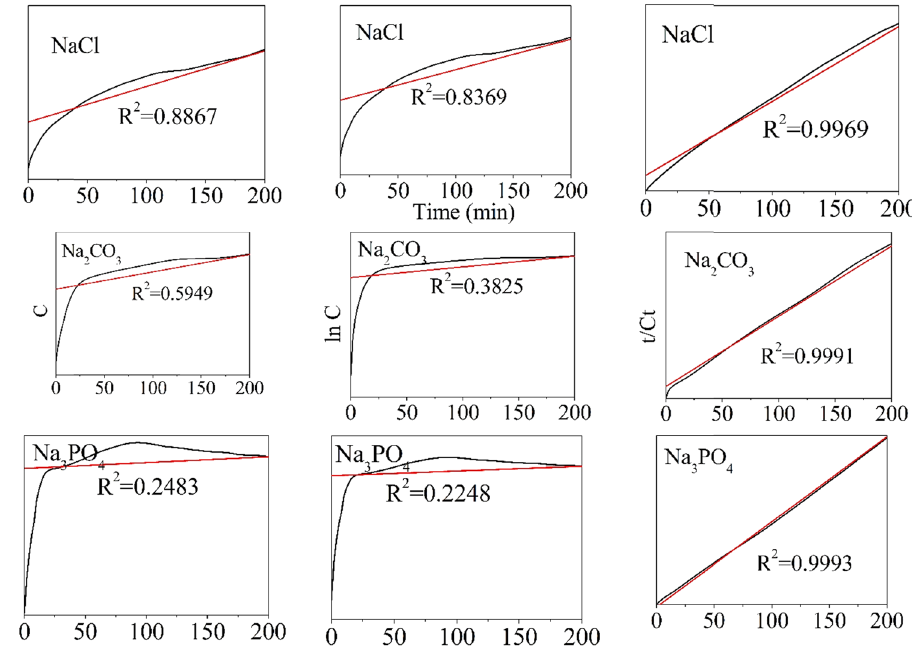
Figure 7: Fitting release data from CaAl - MCPA to zeroth - order, fi rst - order and pseudo - second - order kinetic